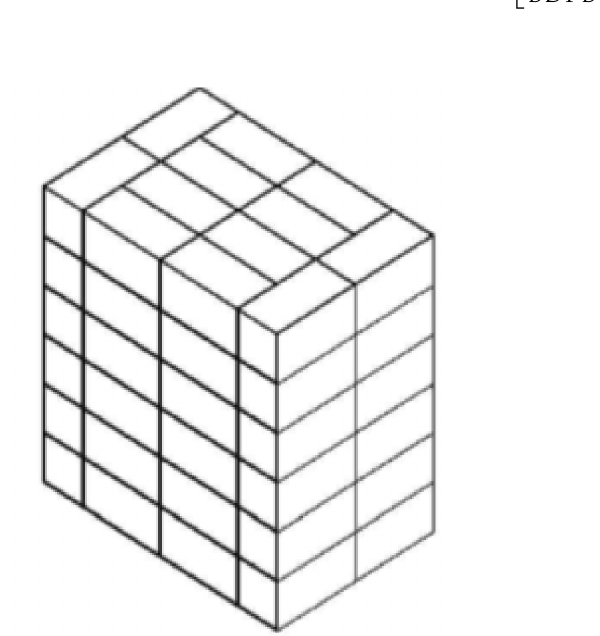
Figure 5. Pallet Loading Problem with identical horizontal layers based on H max . NHL : The maximum number of horizontal layers BDPB : Box’s dimension perpendicular to the